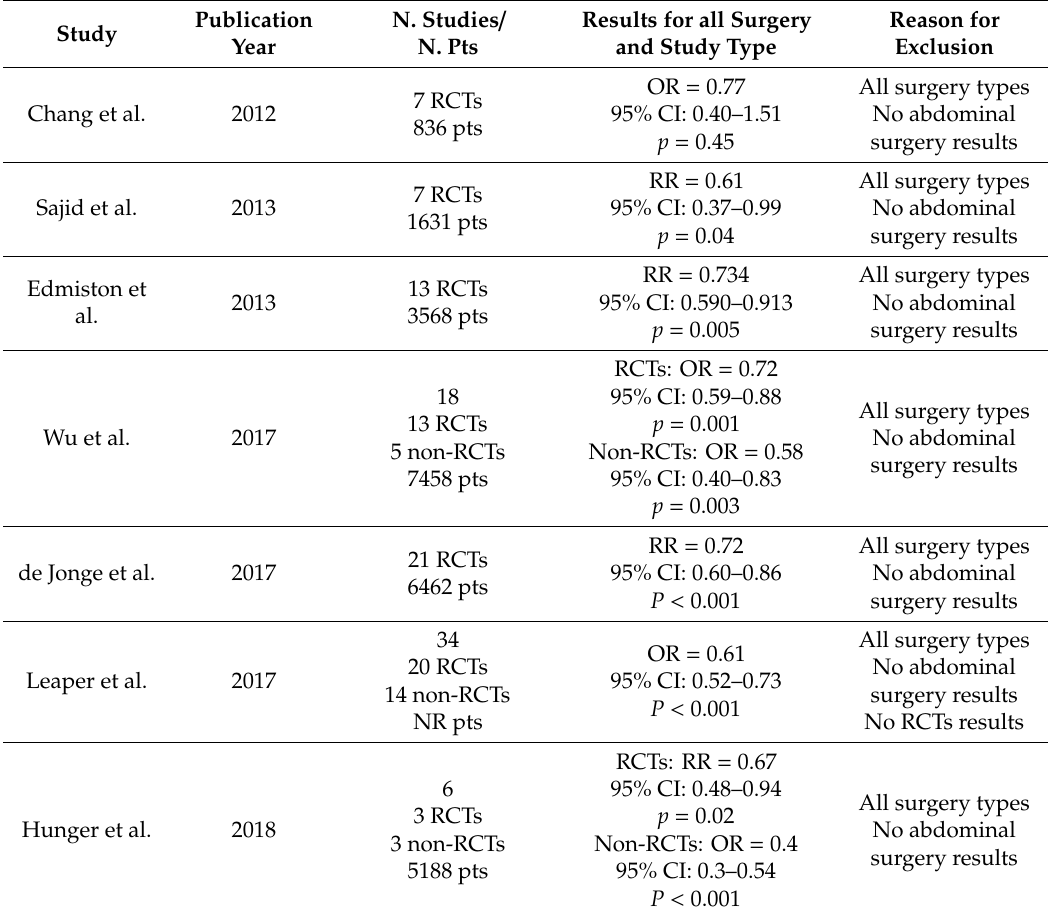
Table A1. Meta-analyses published between January 1990 and June 2019 not included in the study